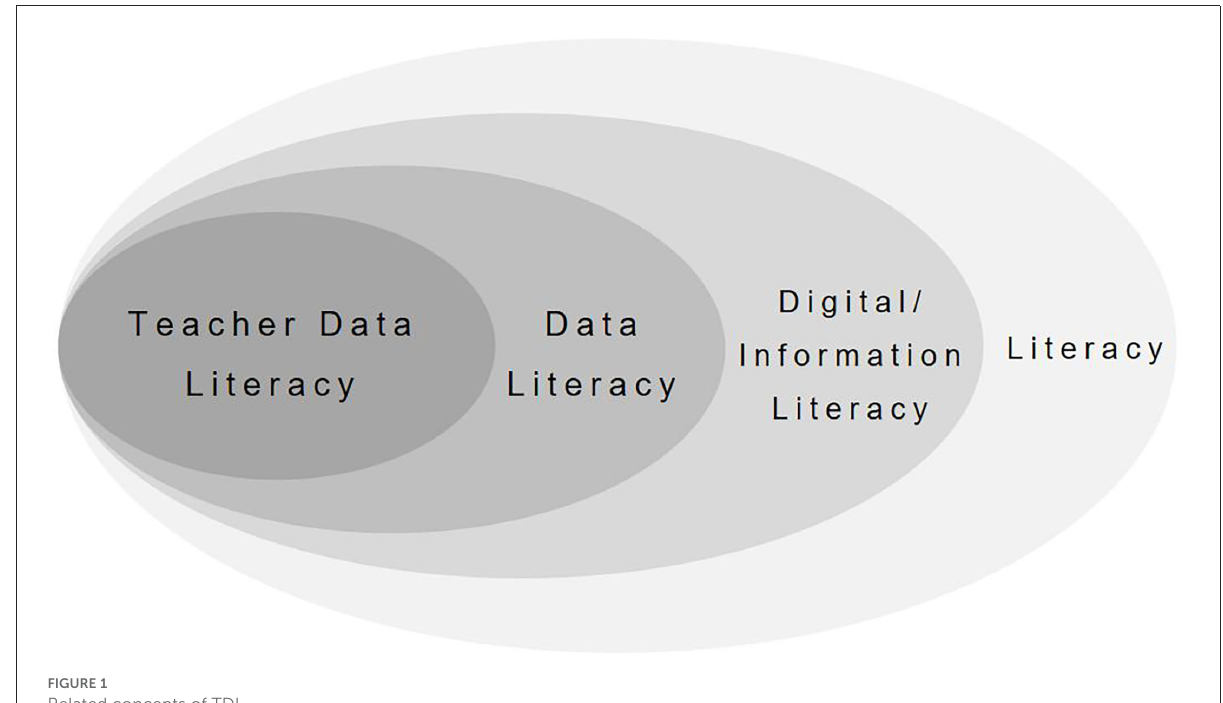
FIGURE1 Related concepts of